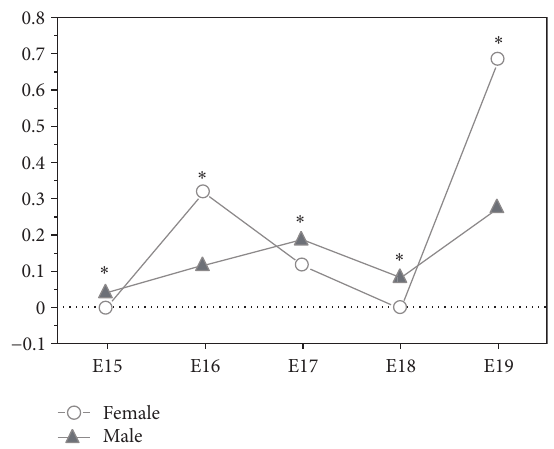
male’s foetuses, retinyl palmitate values were 0.154 ng on day E15, 0.386 ng on day E16 and 0.287 ng on day E17. On the following days, E18 and E19, the values increased to 0.507